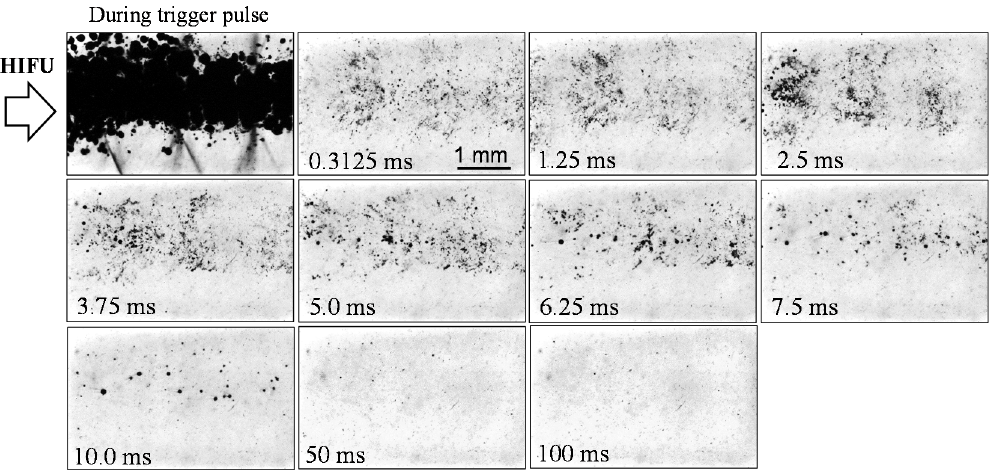
Figure 5. High-speed images of generated and oscillating cavitation bubbles in a PAA gel including 15% BSA by the sequence shown in Figure 1a [36]. A 690-nm pulse laser with a pulse width of 20 ns was used as a backlight source.